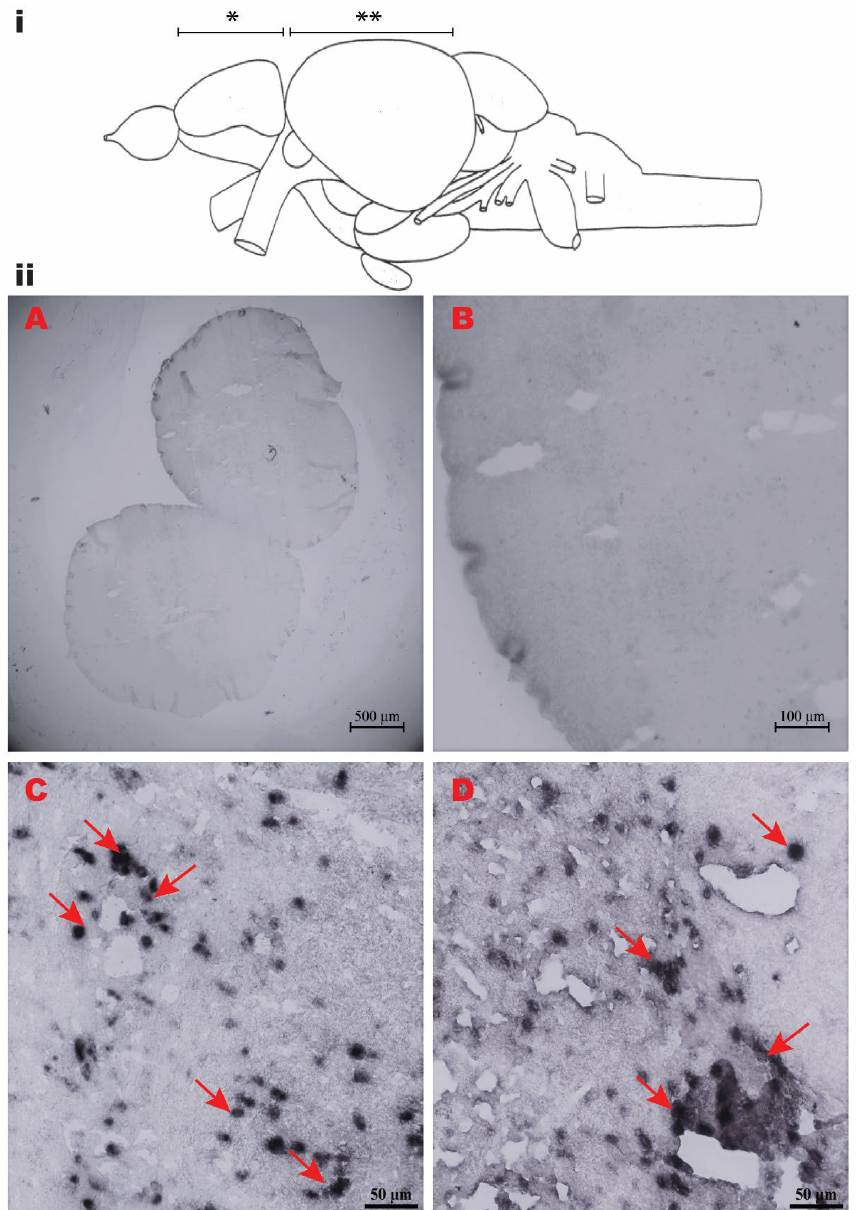
Figure 4. The localization of the npy mRNA-expressing cells in the brain of the spotted scat via in situ hybridization. Sense probe of the npy gene ( A , B ), antisense probe in the telencephalon ( C ), antisense probe in optic tectum region ( D ). Scale bar indicates ( A : 500 μm) ( B : 100 μm) and ( C , D : 50 μm). Note: No signal was detected in the sense probe against the antisense probe. The arrows in ( C , D ) indicate positive signals of the npy gene.